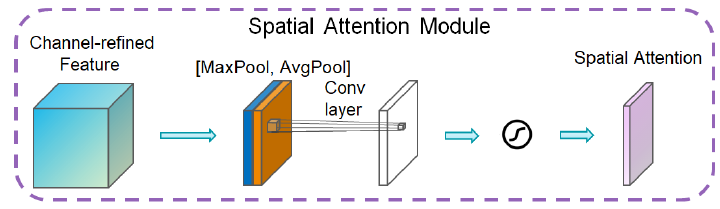
Figure 8. Spatial attention module.